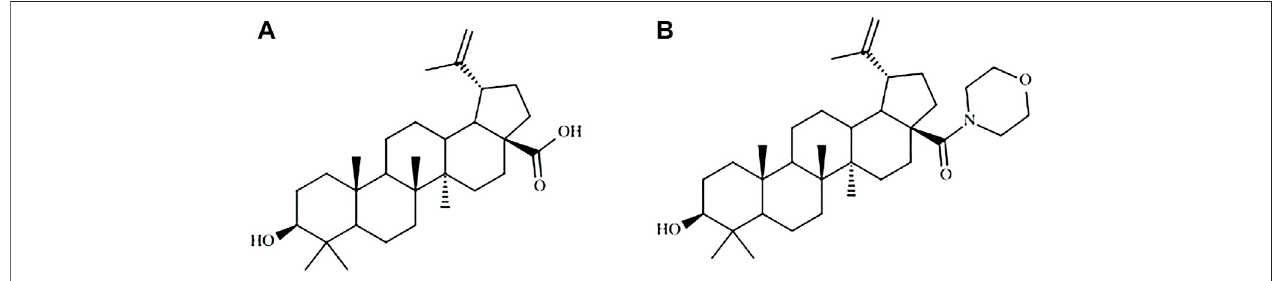
FIGURE 1 | Molecular structures of betulinic acid (A) and BA5 derivative (B) .